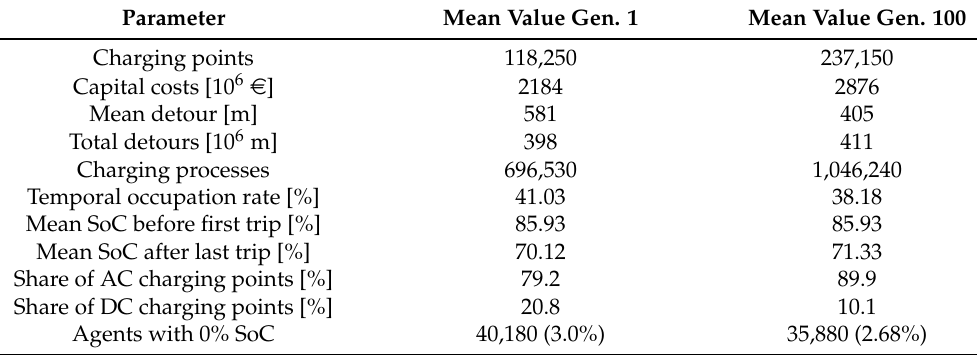
Table 5. Average values of different parameters of generation 1 and generation